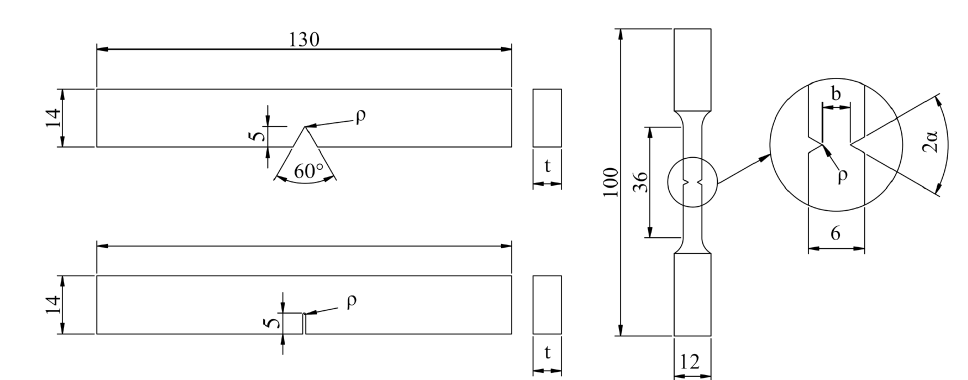
Figure 4. Geometry of specimens tested specimens (dimensions in Table 3. Parameters for stress intensity factor—V-notched.